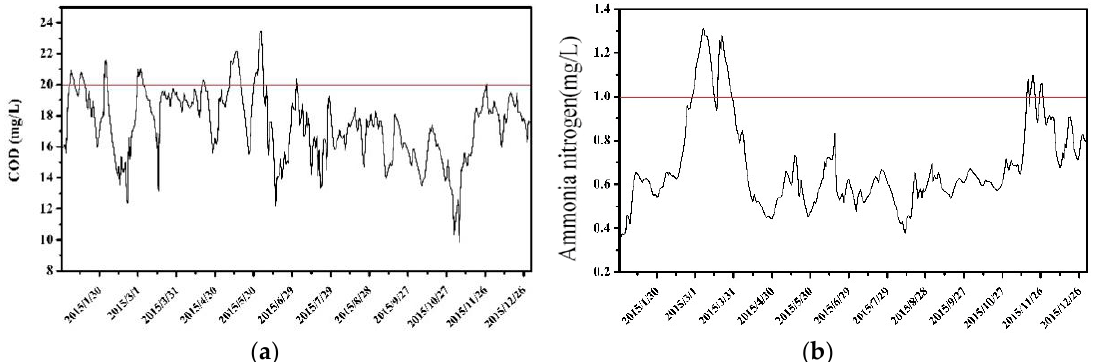
Figure 5. Time series of daily average concentration of pollutants. (the horizontal lines represent the required water quality standard for the control section). ( a ) concentration for COD; ( b ) concentration for ammonia nitrogen.